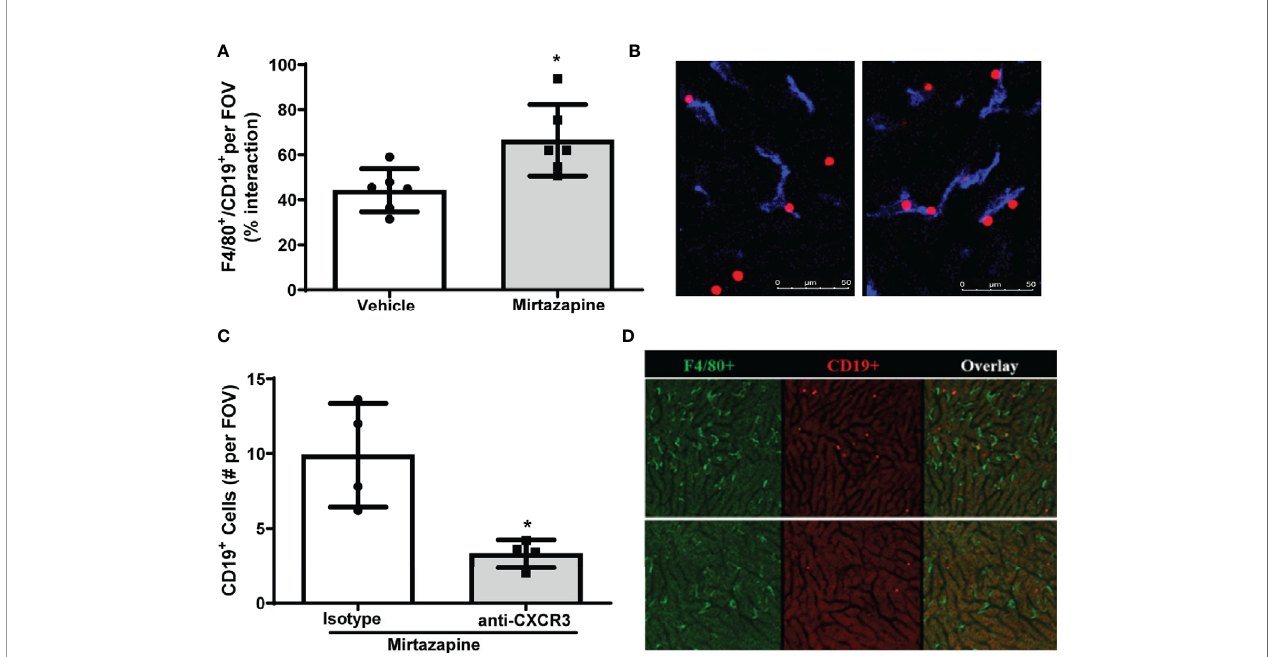
FIGURE 4 | CXCR3 chemokine receptor contributes to preferential retention of B cells within the liver. (A) Quanti fi cation of F4/80 + and CD19 + cell interactions in livers 3 hrs. post-vehicle or mirtazapine treatment (*p ≤ 0.02; n = 6 mice/group). (B) Representative liver IVM image from a mouse 3 hrs post-vehicle (left) and 3 hrs post-mirtazapine treatment (right) showing enhanced intimate B cell (CD19 + ; red) and Kupffer cell (F4/80 + ; blue) interactions in mirtazapine vs vehicle treated mice. (C) Reduction in hepatic B cells in mirtazapine-treated mice after CXCR3 blockage. B cells (CD19 + ) were counted in at least 5 FOV images/mouse (*p ≤ 0.05 n = 4 mice/group). (D) Representative liver IVM images from mice 3 hrs. post-treatment. Mirtazapine + isotype control upper panels, and mirtazapine + anti-CXCR3 neutralizing antibody (lower panels). Green staining indicates F4/80 + Kupffer cells and red staining indicates CD19 + B